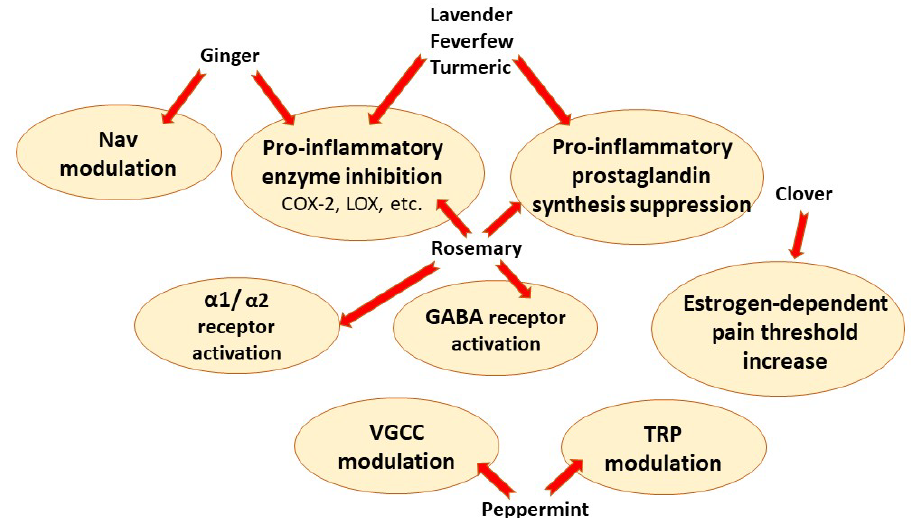
Figure 4. Main analgesic mechanisms of herbal painkillers. Nav—voltage gated sodium channels, TRP–transient receptor potential channels, VGCC—voltage-gated calcium channels, COX-2—cyclooxygenase 2, LOX—5-lipoxygenase.